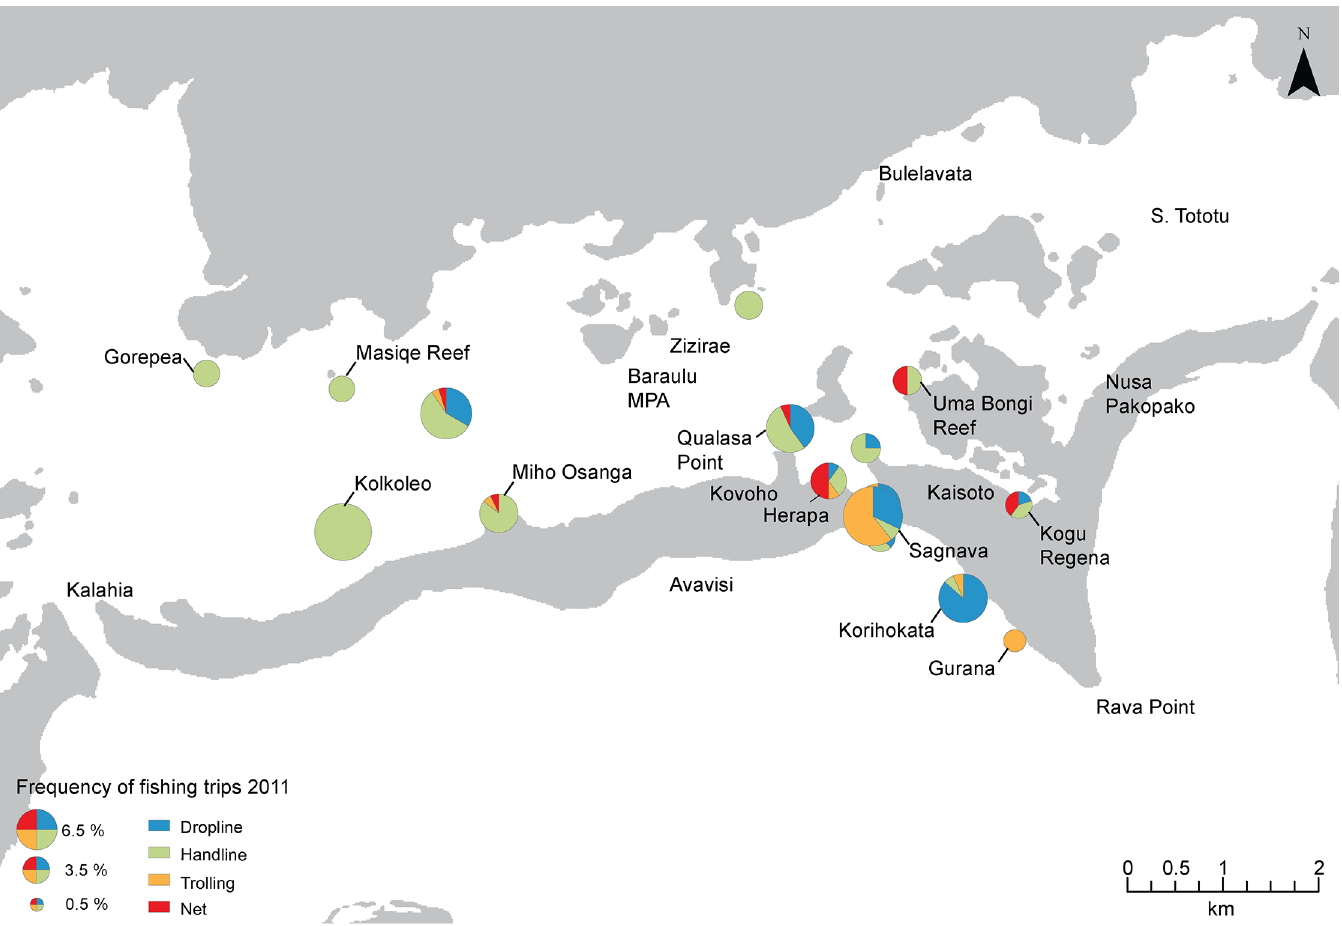
Fig 4. Proportion of fishing time and methods spent across fishing sites within the Roviana lagoon study area in 2011. Size of pie chart symbol denotes the the anmount of time spent at fishing locations throughout the Roviana lagoon during the 2011 record period. The amount of time spent for each method is shown by pie chart